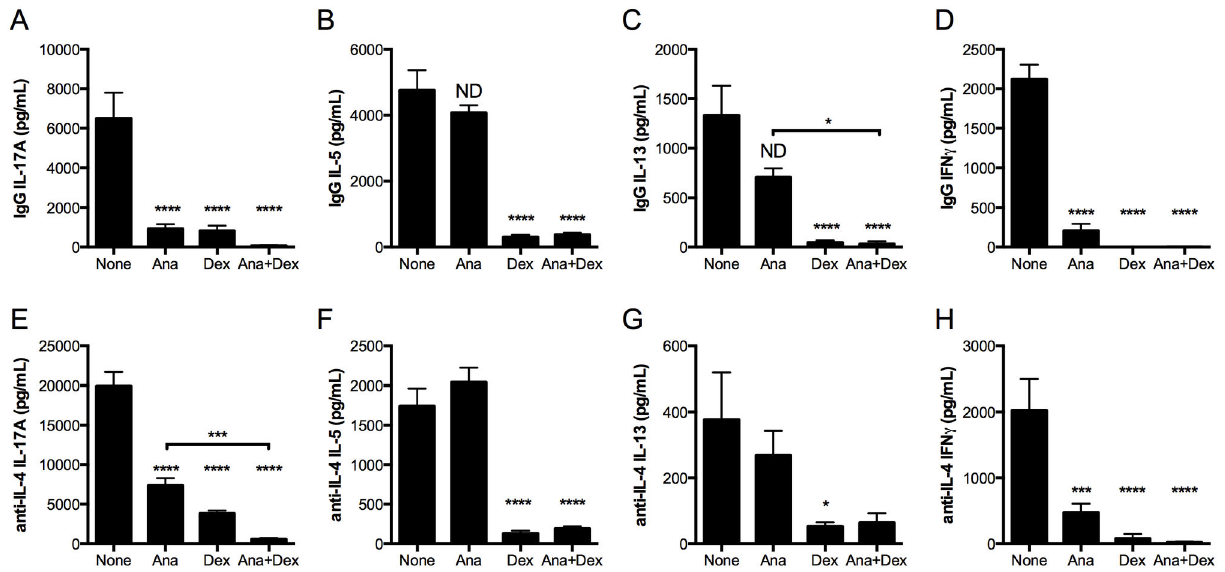
Figure 5. Inhibition of the Th2 response with anti-IL-4 antibodies does not confer anakinra or Dex resistance in IL-17A production by antigen-restimulated lung cells in NO -promoted allergic airway disease. Mice were treated as in Figure 2. 2 Lung single cell suspensions were restimulated with OVA antigen in the presence or absence of anakinra (Ana; 1 μg/mL), Dex (10 -8 M), or anakinra and Dex in combination for 96 hours. Cell supernatants from antigen-restimulated and treated lung cells from IgG isotype control treated mice (A-D) or anti-IL-4 treated mice (E-H) were analyzed for cytokines by ELISA. Statistics were performed by one-way ANOVA and Bonferroni post hoc analysis (E-L). **** p < 0.0001, *** p < 0.001, ** p < 0.01, * p < 0.05 compared to controls (none) unless otherwise indicated by brackets. ND, not significantly different compared to controls. n = 6-12 per